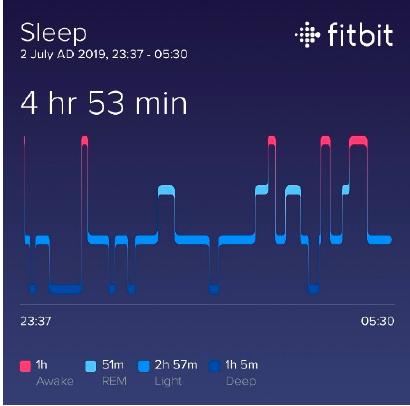
Figure A9. Shanghai,